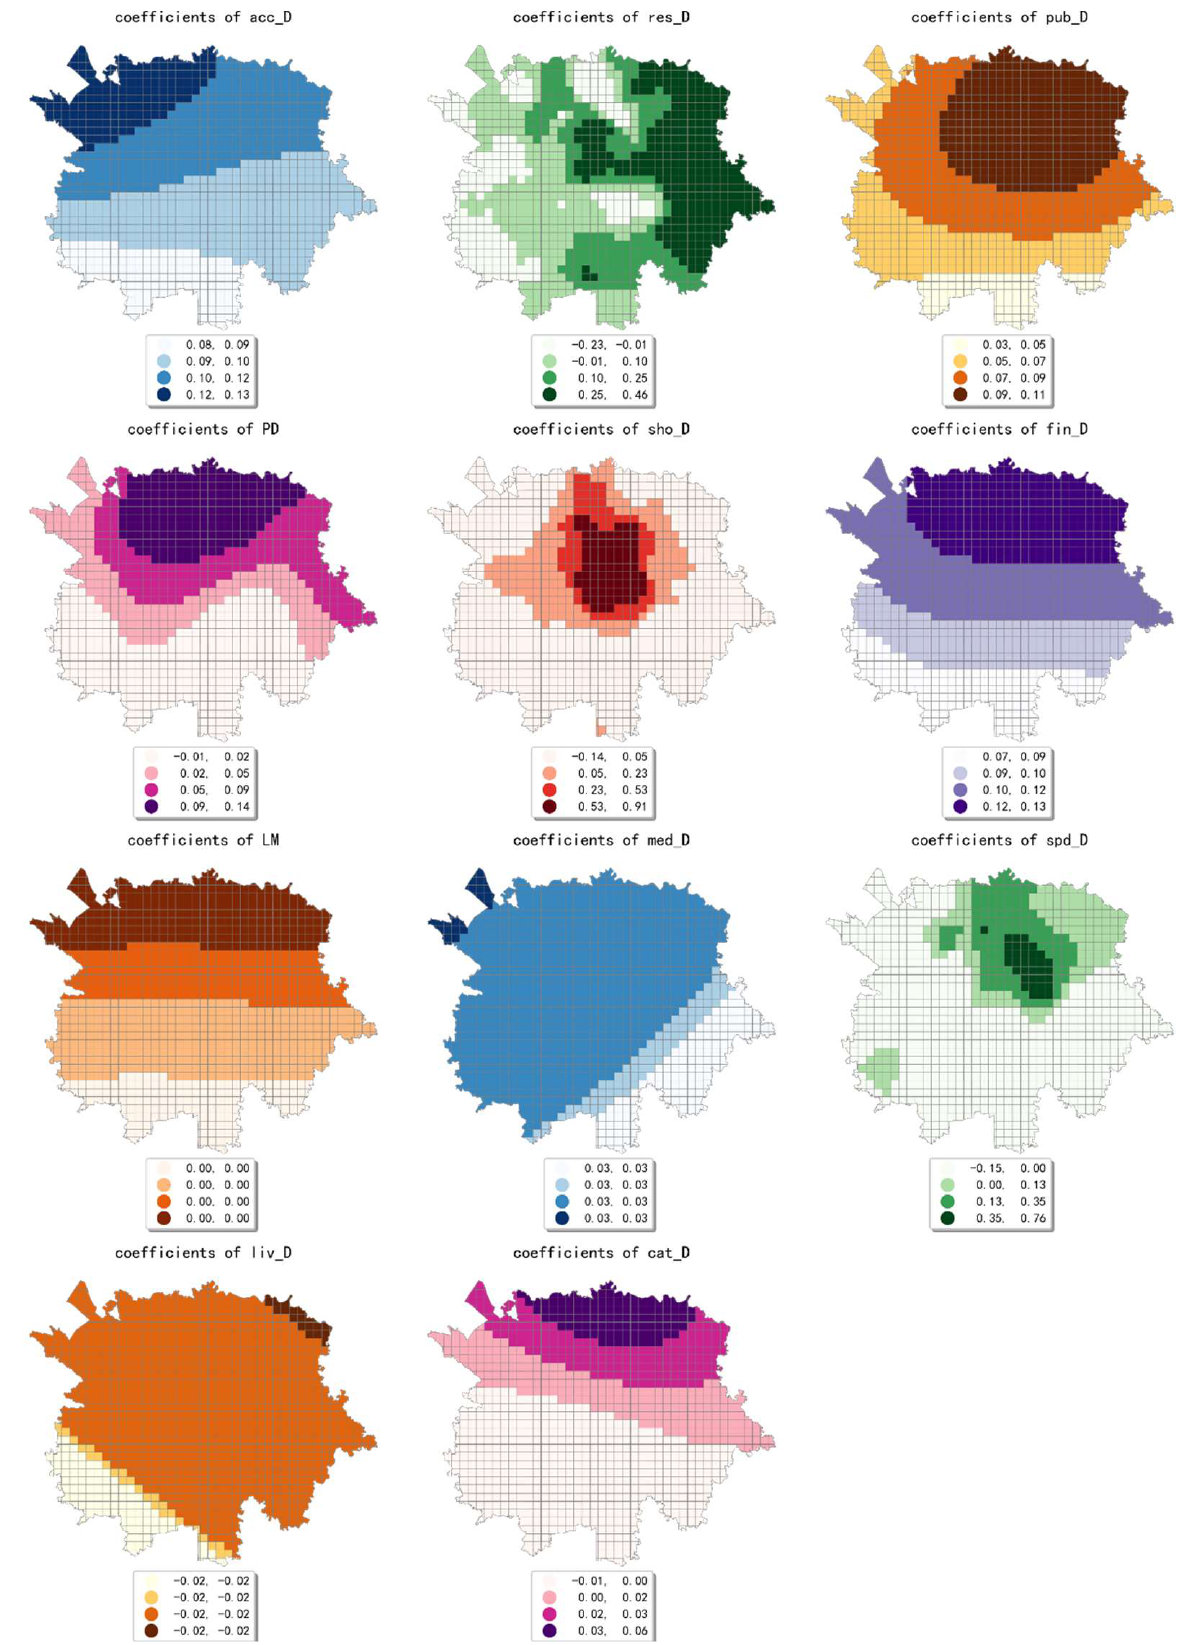
Figure 3. The estimated coefficient maps in the grid with 1000 m.